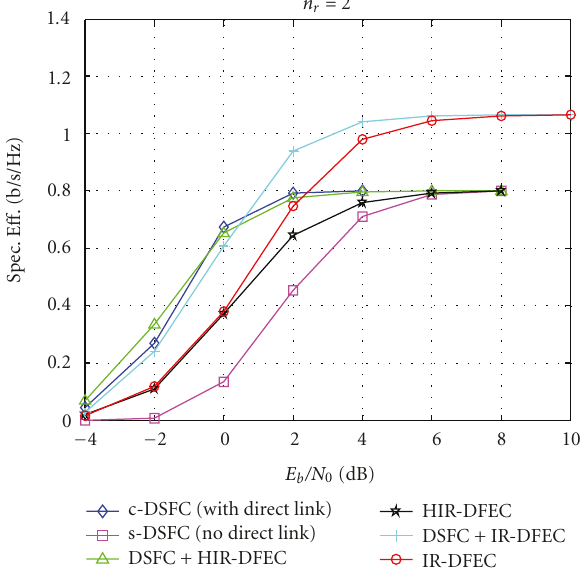
Figure 10: Spectral e ffi ciency versus E b /N 0-direct —modified D1— n d = 2, n r = 4.